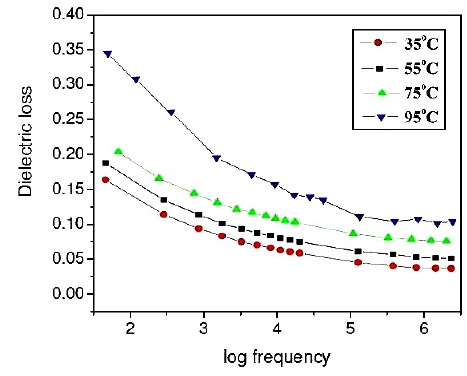
Fig.9. Variation of dielectric loss with log